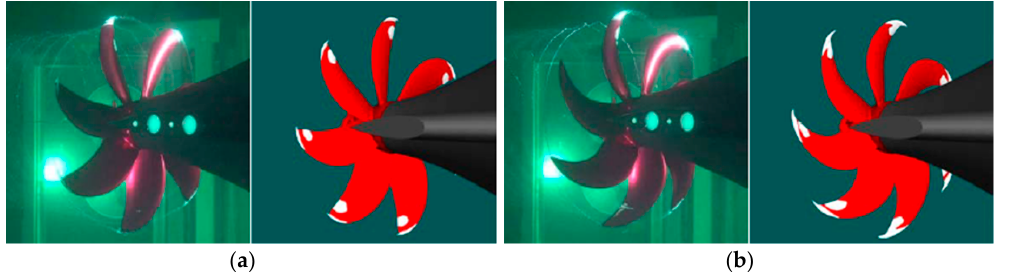
Figure 7. Comparison of predicted cavitating flow of underwater propellers of a submarine with the experimental ones for ( a ) Model-A and ( b ) Model-B.